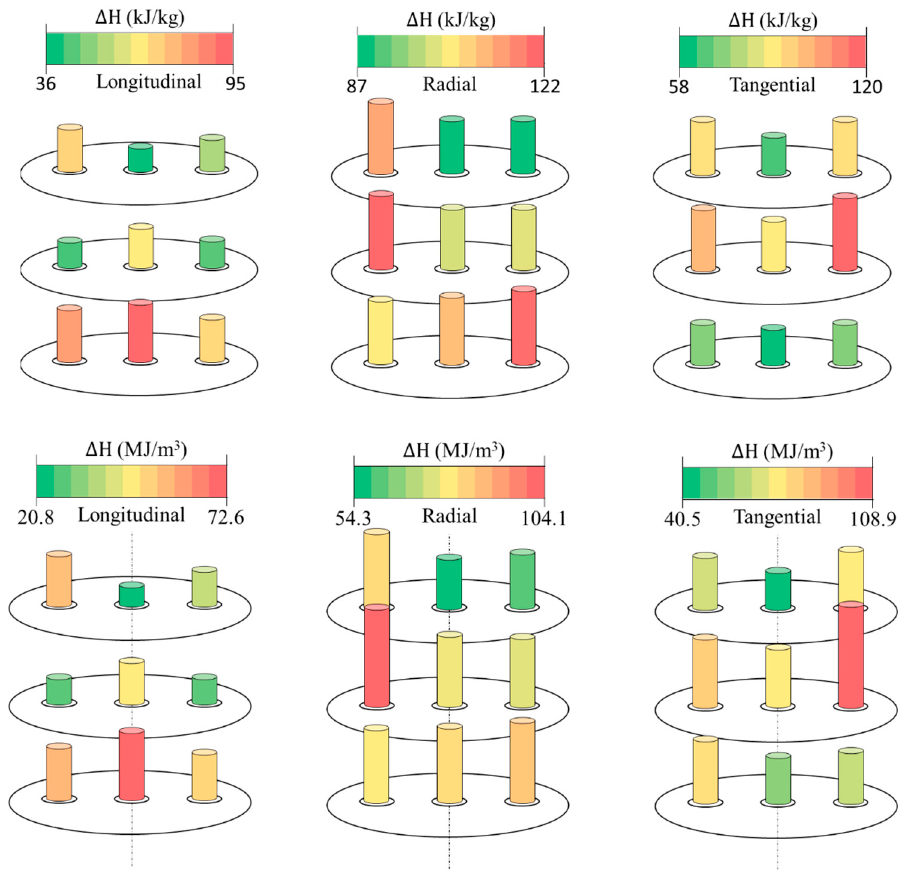
Figure 14. Distribution of the latent heat at different positions for wood samples impregnated with octadecane. Energies 2019 , 12 , x FOR PEER REVIEW 14 of 17